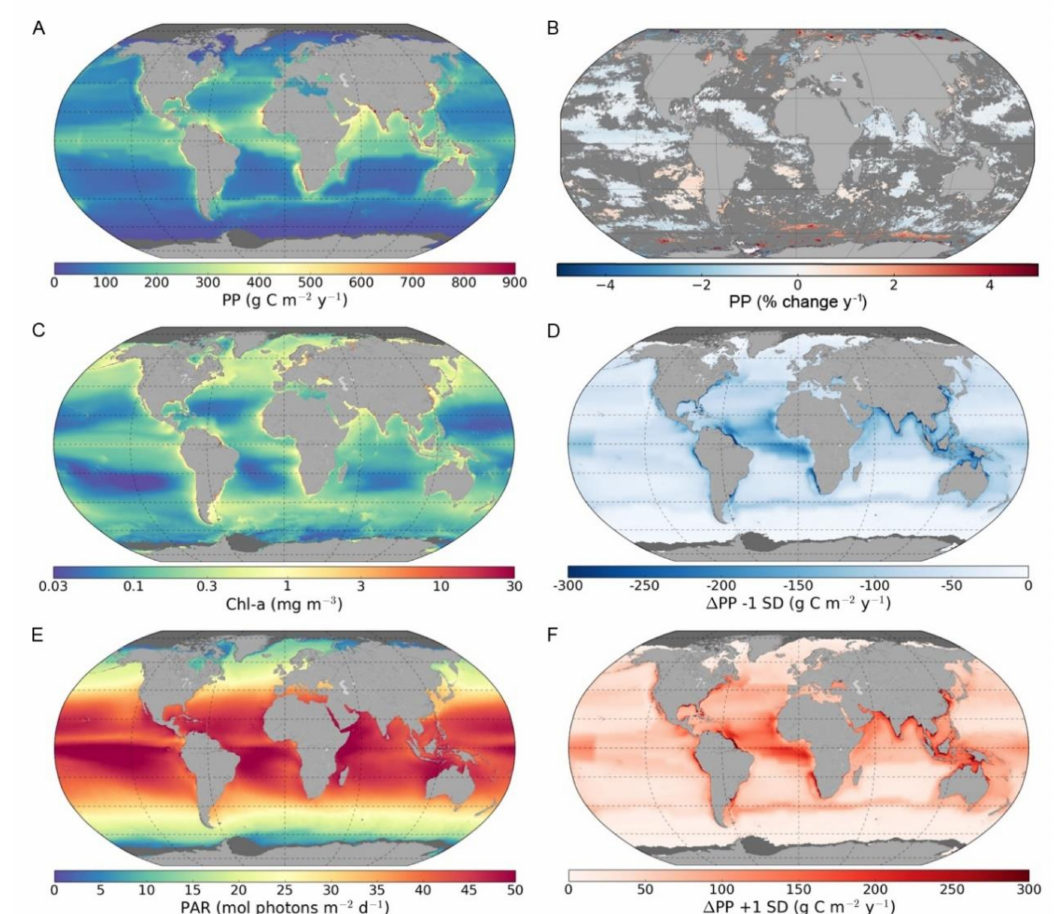
Figure 3. Maps of global annual primary production (PP) and associated parameters for the period of 1998–2018: ( A ) global annual primary production based on mean photosynthesis versus irradiance (P-I) parameters; ( B ) linear trends in global annual primary production between 1998 and 2018 given as percentage change per year (dark grey colour represents non-significant trends); ( C ) remote-sensing-derived mean surface chlorophyll- a (Chl-a); ( D ) difference in primary production between mean P-I parameters and –1 standard deviation (–1 SD)-based estimations; ( E ) remote-sensing-derived Photosynthetic Active Radiation (PAR, 400–700 nm); and ( F ) difference in primary production between mean P-I parameters and +1 standard deviation (+1 SD)-based